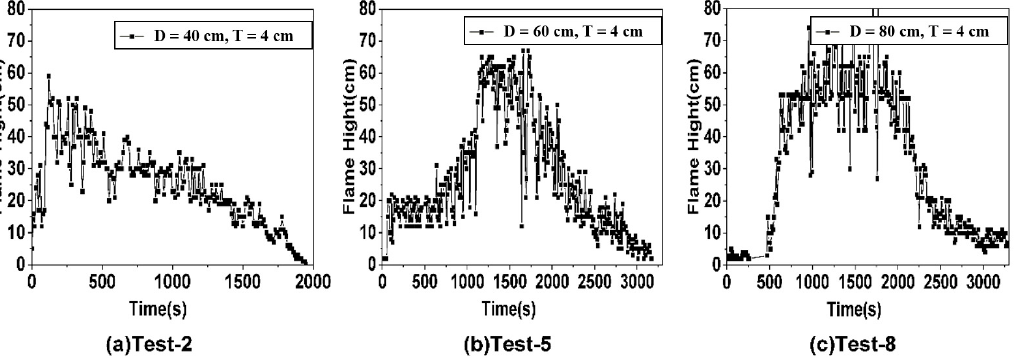
Figure 7. The flame height changes from Test-2, Test-5, and Test-8 (where ( a ) is a coal pile of 40 cm diameter and 4 cm thickness, ( b ) is a coal pile of 60 cm diameter and 4 cm thickness, ( c ) is a coal pile of 80 cm diameter and 4 cm thickness).